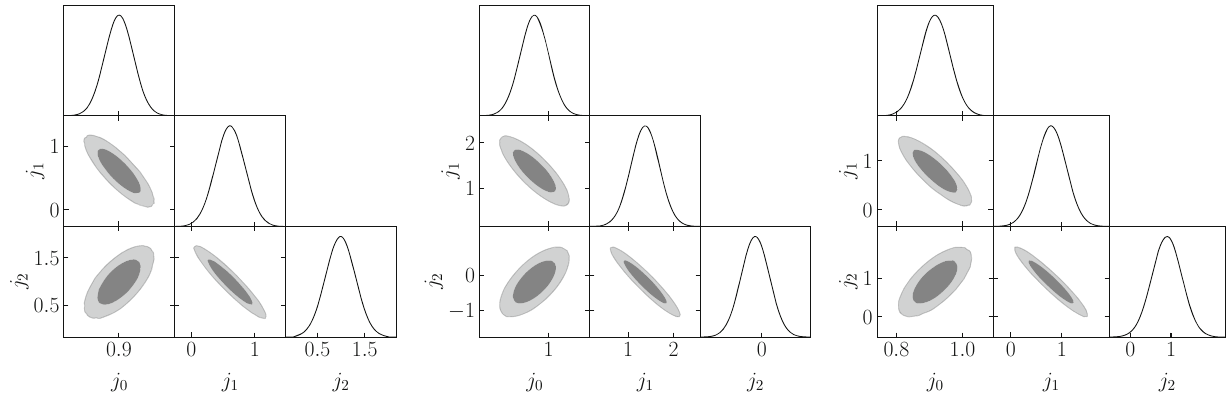
Fig. 14 Plots showing the correlations between the fit parameters, j i ’s. The shaded regions show the confidence contours on the parameter space of j 0 , j 1 and j 2 respectively for CC + Pantheon (left), CC + Pantheon + P18 (middle) and CC + Pantheon + R19 (right)